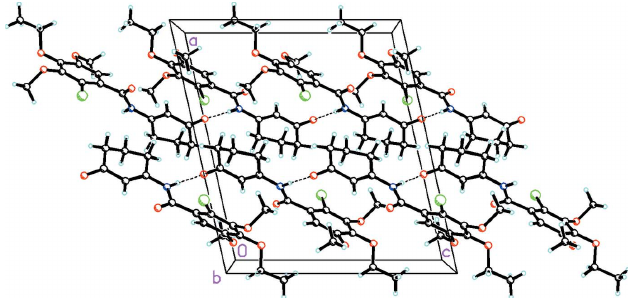
Figure 4 Packing diagram for 3a viewed along the b axis showing the molecules linked by N—H (cid:3)(cid:3)(cid:3) O hydrogen bonds (shown by dashed bonds) into chains propagating in the [001] direction